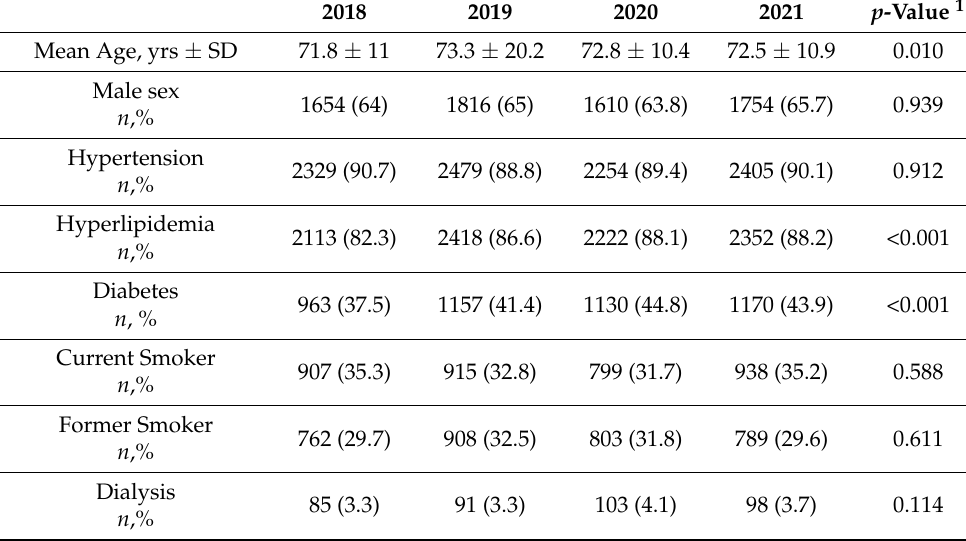
Table 1. Cardiovascular risk factors.